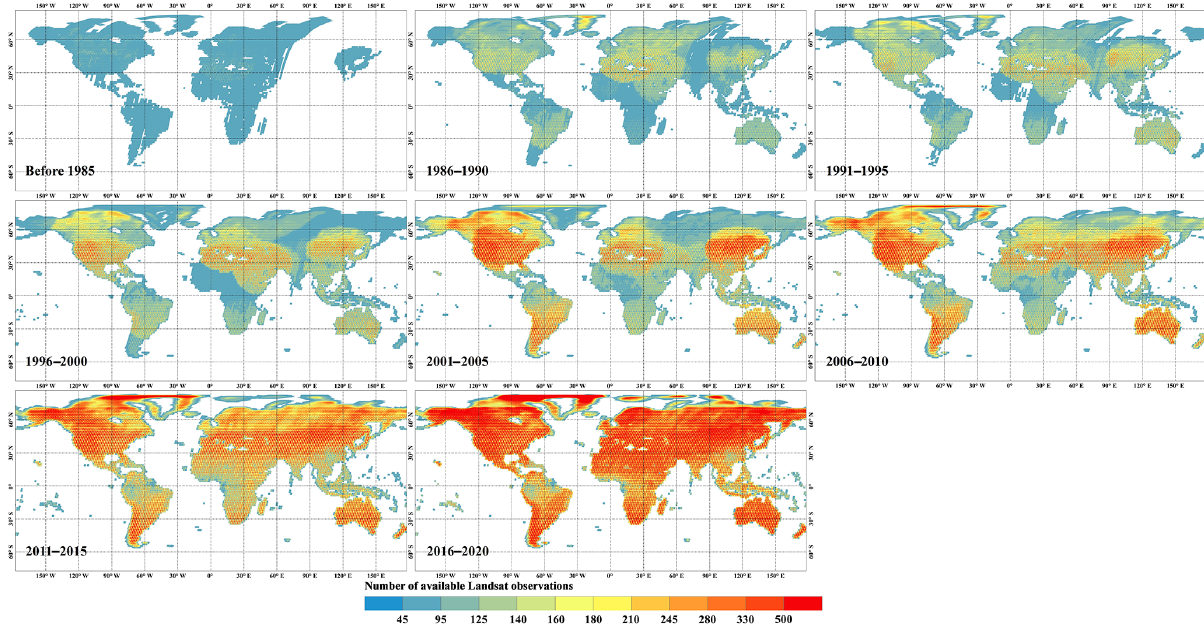
Figure 1. The spatial distributions of the available Landsat observations from 1985 to 2020 with 5-year intervals.